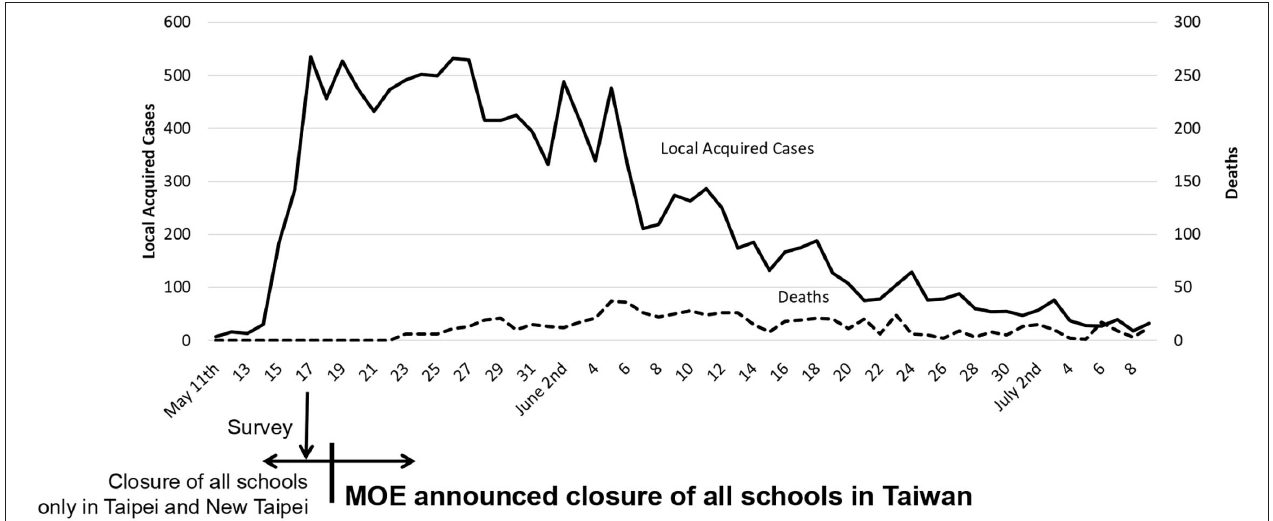
FIGURE 2 | Number of new daily local acquired COVID-19 cases and the timing of the survey of SOSC-19. Data excludes 1–10 imported cases per day (Ministry of Health and Welfare).